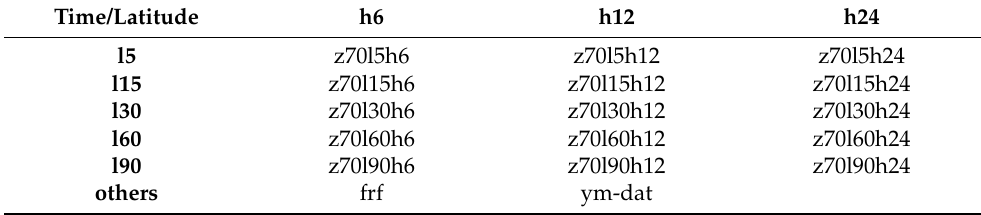
Table 1. Cases of idealized wind observations for observing system simulation experiments. Ideal- ized wind observations at 70 km are assumed to be derived from images of ultraviolet wavelength camera on the Akatsuki orbiter. Headings in the vertical column indicate latitudinal range of ob- servations and headings in the horizontal row indicate frequency of observations. For example, bottom row, “frf” means free run forecast (without data assimilation) and “ym-dat” means the original CCSR/NIES VGCM [19] full data set used for idealized